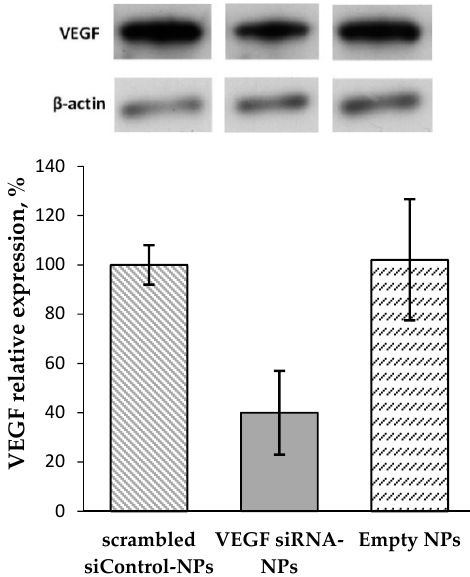
Figure 7. VEGF protein expression in the ARPE-19 cells determined by western blotting (KEI2 NPs).